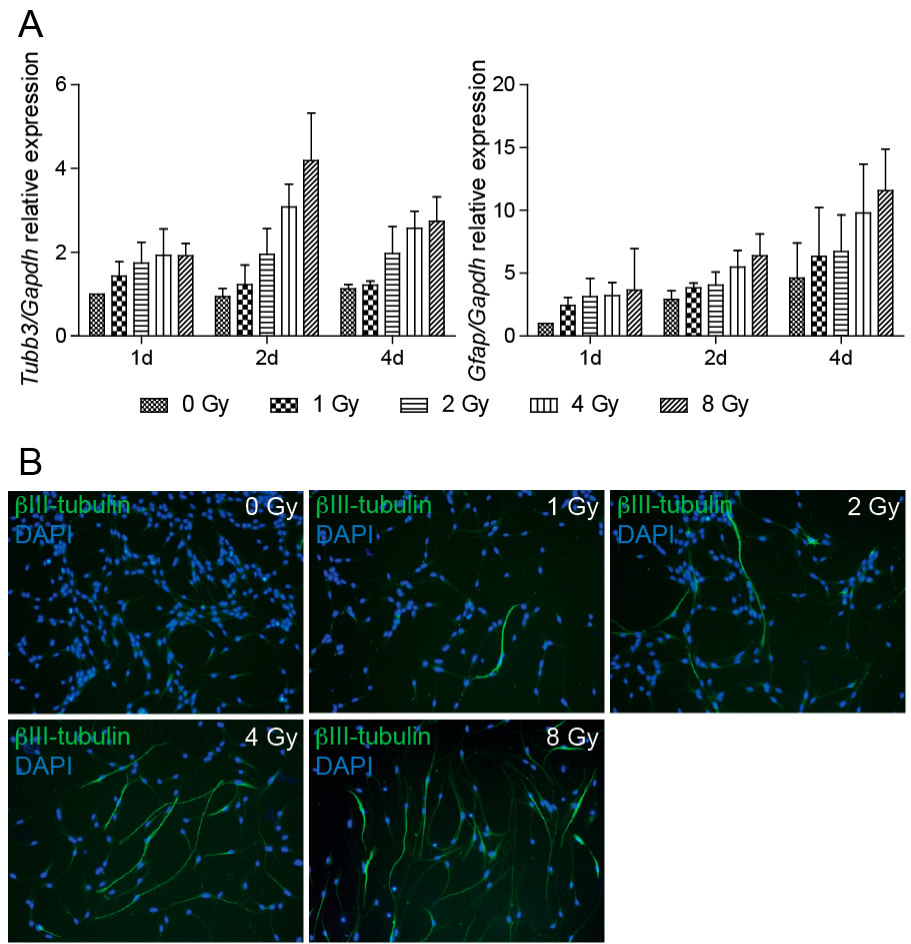
Figure 5. Radiation promotes NSC differentiation. ( A ) Quantitative RT-PCR analysis of mRNA levels of Tubb3 and Gfap genes at 1, 2, and 4 days after irradiation to 0, 1, 2, 4, and 8 Gy doses. Gapdh was used as a reference gene. Tubb3 : p < 0.0001, Gfap : p = 0.0002. ( B ) Representative immunofluorescence images of NSCs 4 days after irradiation to 0, 1, 2, 4, and 8 Gy doses stained with β III-tubulin antibody (green). DAPI (blue) was used to stain the nuclei. Original magnification 100 × .